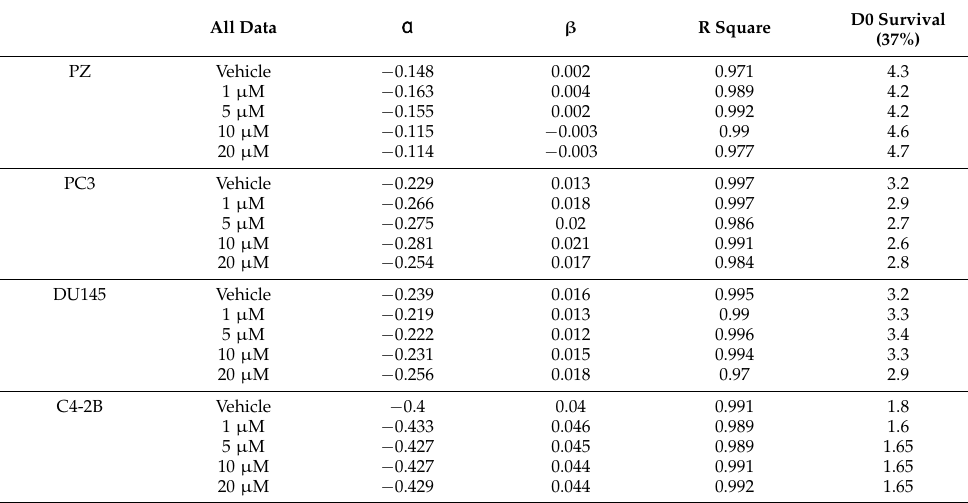
Figure 2. BET induces PCa cell death while increasing non-cancer prostate cell viability through mediation of H 2 O 2 production. Cells were treated with 5 µ M BET at various time points. ( A ) Cell viability based on MTT assay. ( B ) Extracellular H 2 O 2 production ( µ M) based on Amplex Red method (24 h). ( C ) Intracellular H 2 O 2 production was measured using the aminotriazole-(3-AT)-mediated inactivation of CAT method (6 h). ( D , E ) Cell viability after treatment with PEG-CAT prior to BET. * p -value ≤ 0.05 when compared with vehicle. n = 3. Table 1. BET as a radioprotector of non-cancer prostate cells (PZ) and a radiosensitizer of PCa cells: PC3, DU145, and C4-2B. α represents single-hit kill and β two-hit kill, which correlate with low-dose killing and high-dose killing.